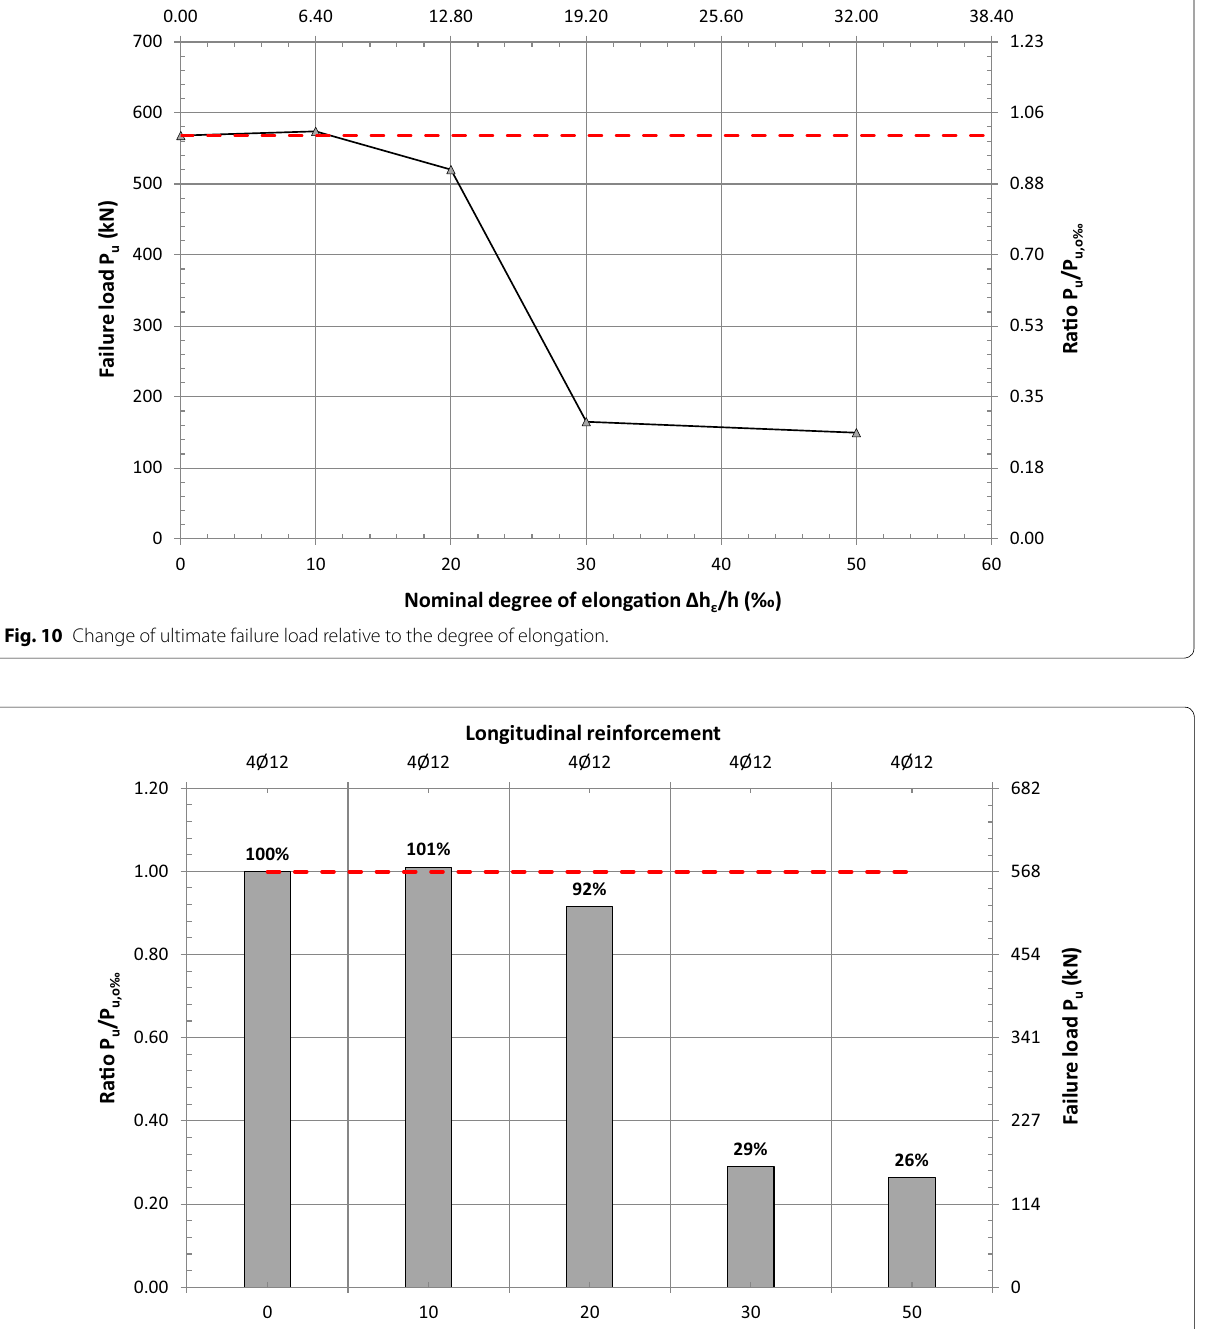
increase can be explained in the differences which exist regarding the concrete strength. All five speci- mens were constructed using concrete from the same